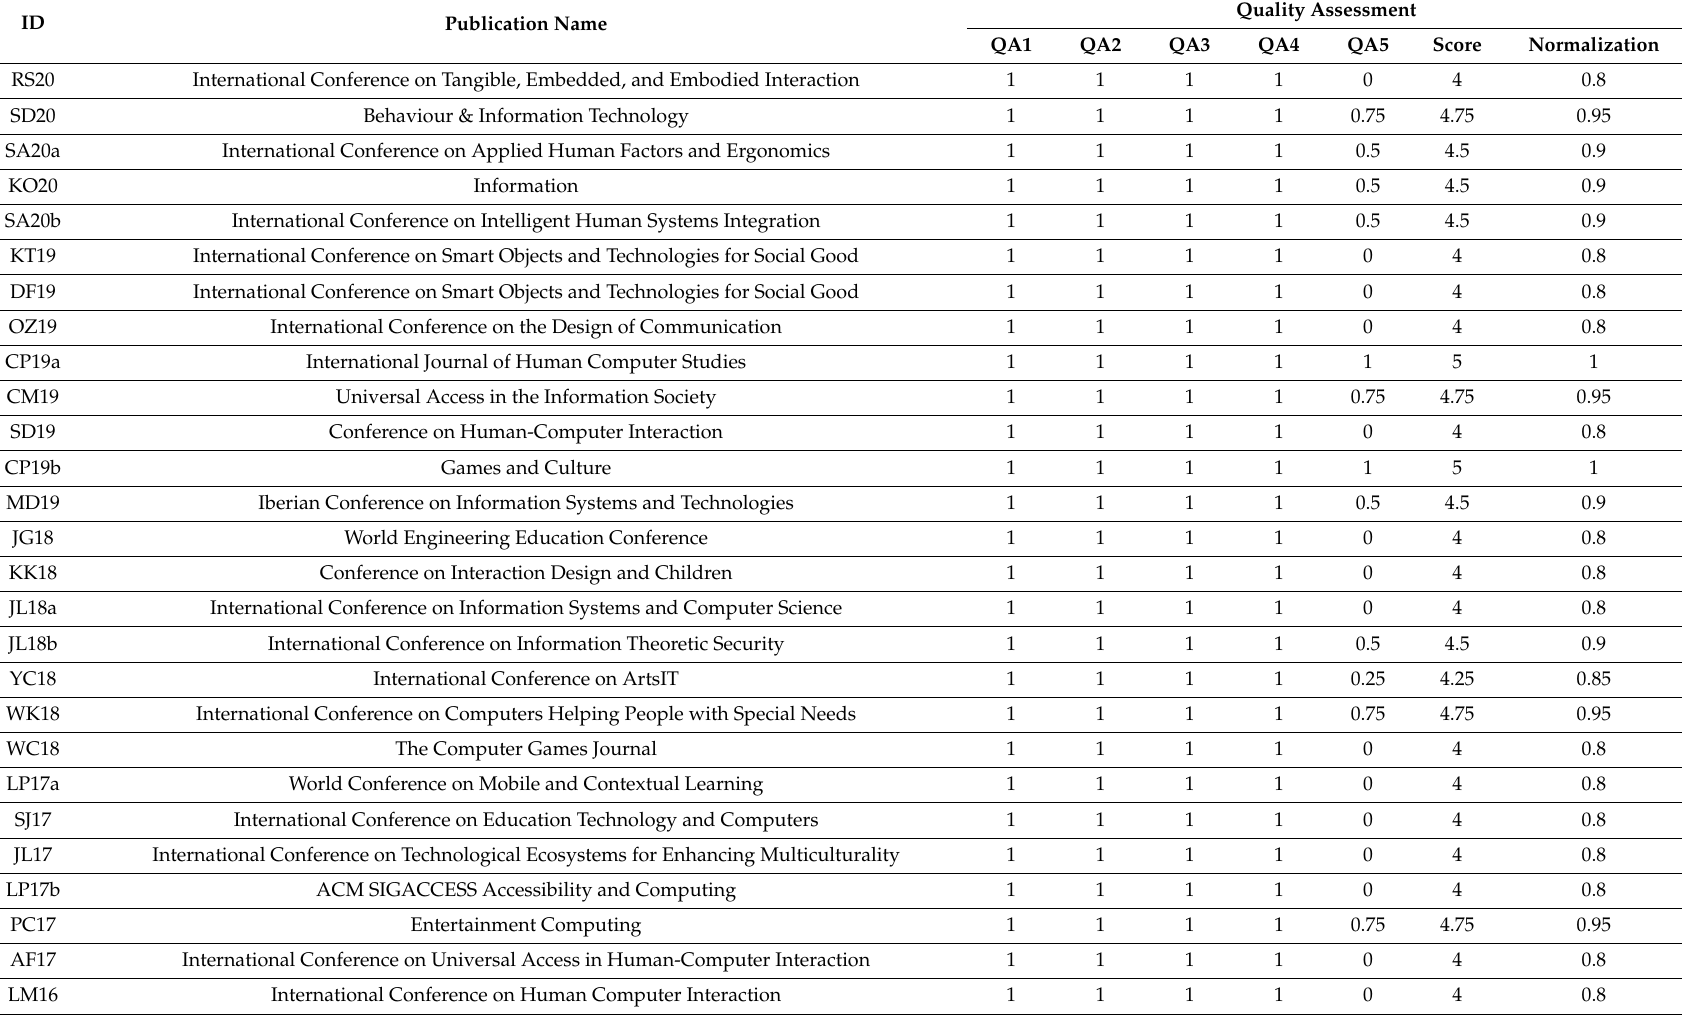
Table 4. Selected papers and quality assessment